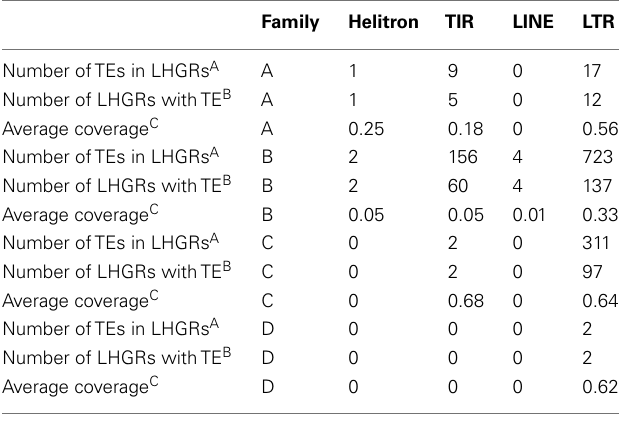
Table 5 |The distribution of transposable elements across LHGRs.